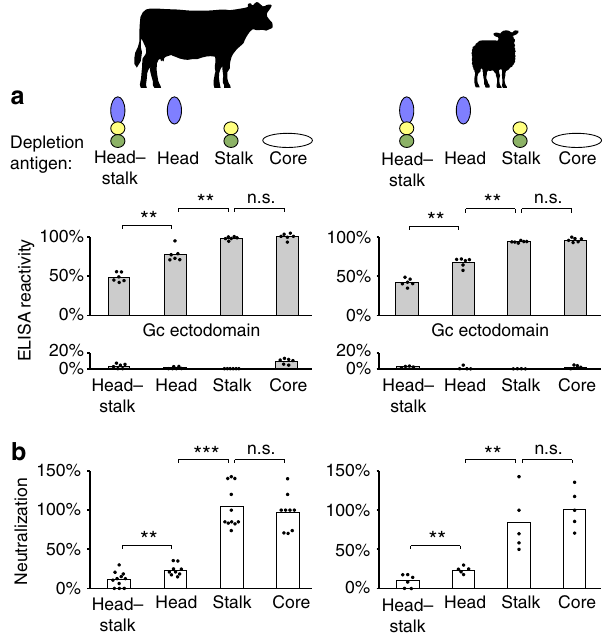
Fig. 3 The SBV Gc head domain is the major target of neutralizing antibodies in its natural hosts. a Antibody subpopulations were depleted from three cattle sera (left) and one sheep serum (right) collected 28 days after experimental infection with SBV. The above-indicated recombinant depletion antigens were head – stalk (aa 465 – 874), head (aa 465 – 702), stalk (aa 694 – 874), and core (aa 890 – 1326). The histogram shows ELISA reactivity after depletion with the full Gc ectodomain (aa 465 – 1326, top) or with the respective depletion antigens (below). Bars represent mean percentages of mock-depleted sera, the optical density values of which ranged robustly between 3.2 and 3.6 for reactivity with the Gc ectodomain. Owing to saturation effects, ELISA reactivity is likely not linearly proportional to the absolute binding activity in a sample. b Virus neutralization after depletion with the indicated antigens for the three cattle sera (left) and the sheep serum (right). Bars represent mean percentages of mock-depleted sera. Dots represent technical replicates.